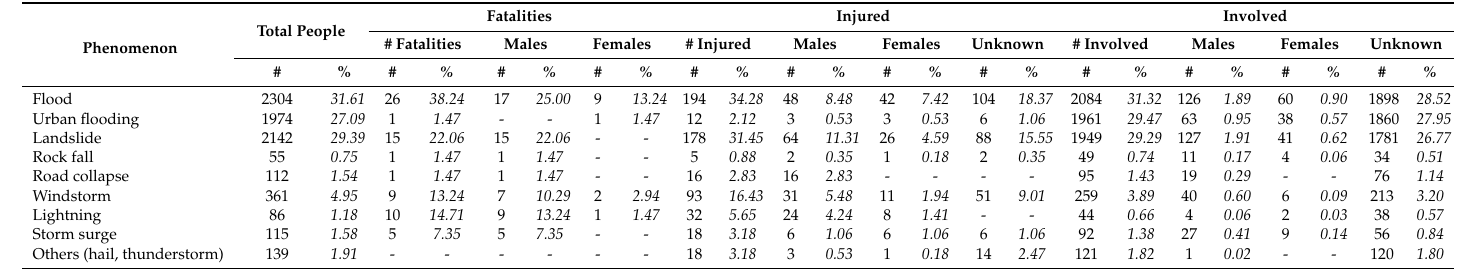
Table 6. Relationship between type of phenomenon and